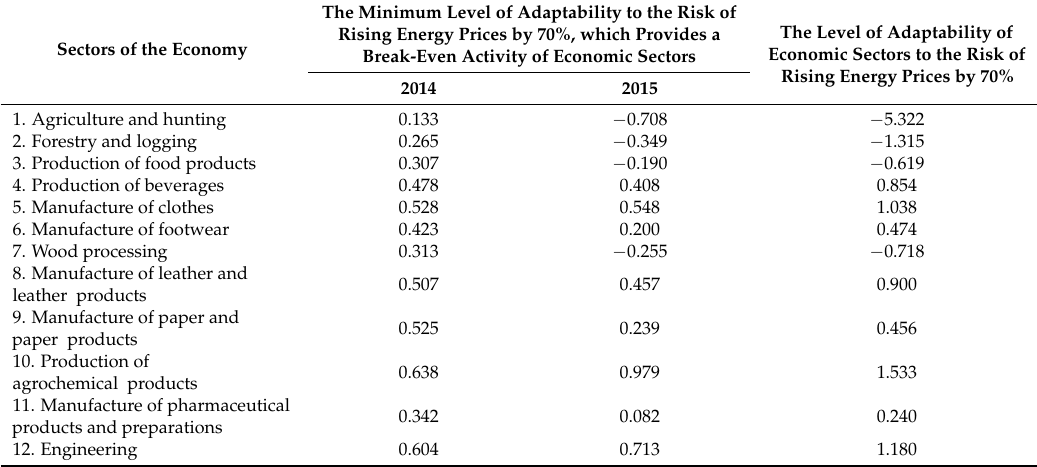
Table 7. Results of the assessment of the level of adaptability of Ukrainian economic sectors to the risk of rising energy prices by 70% in 2014–2015.